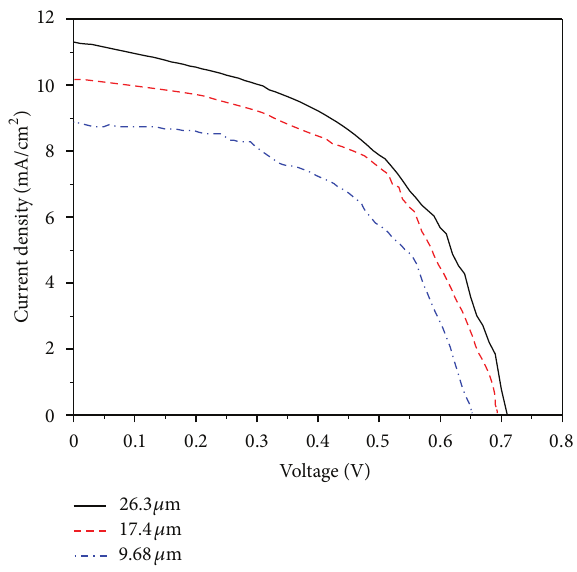
Figure 6: Current-voltage characteristics of the dye-sensitized solar cells under